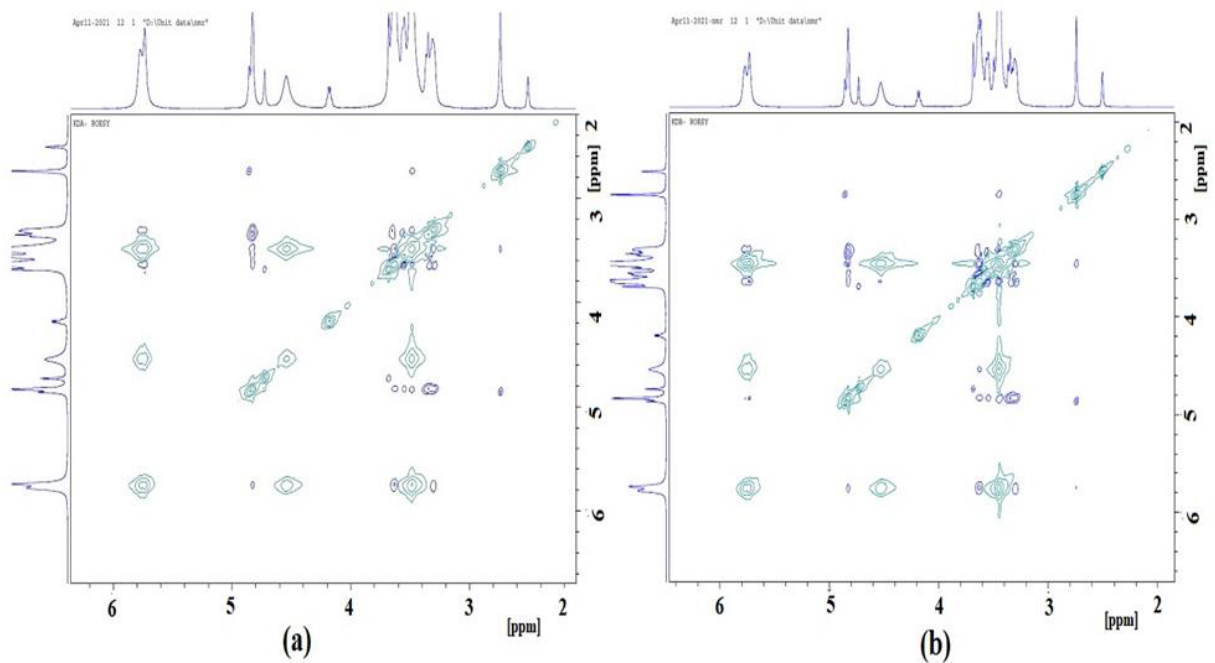
Figure 8. 2D ROSEY NMR spectra of ( a ) the kneaded binary complex ADL/β-CD (KDA); ( b ) the optimized kneaded ternary complex ADL/β-CD with 1% poloxamer 188 (KDB).